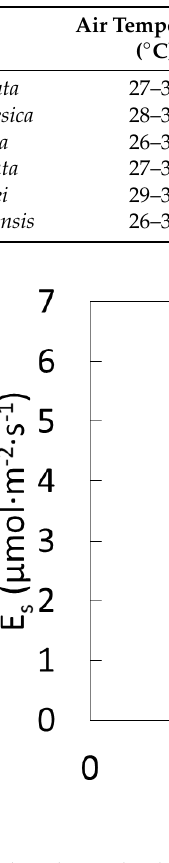
Figure 3. The relationship between stem diameter and stem carbon dioxide efflux ( E s ) for six arborescent Cycas species.